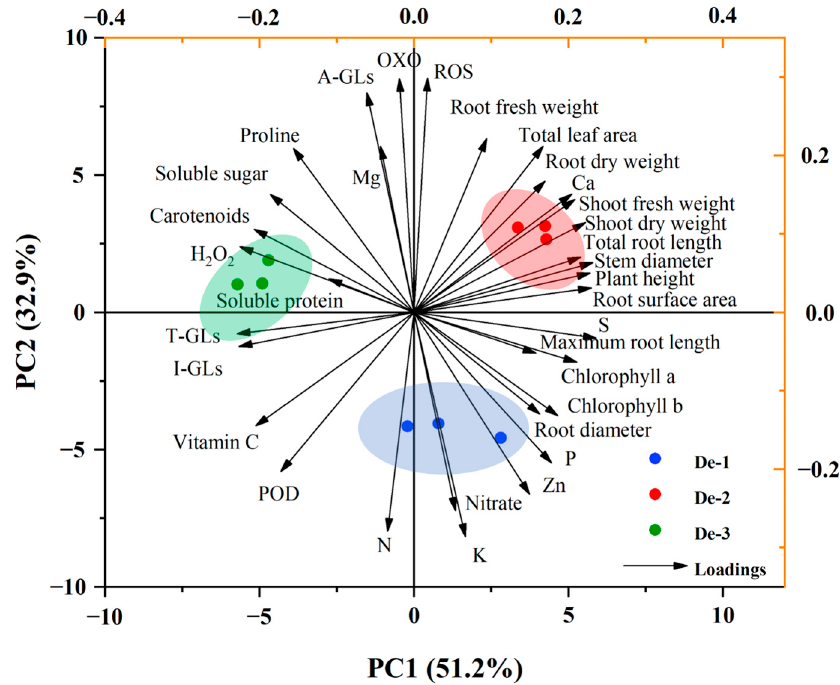
Figure 9. Principal component analysis (PCA) shows differences and correlations in kale grown under different nutrient-solution depths. Scatter plots with different colors indicated three treatments ( n = 3). ROS, reactive oxygen species; H 2 O 2 , hydrogen peroxide; OXO, oxalate oxidase; POD, peroxidase; A-GLs, aliphatic glucosinolates; I-GLs, indole glucosinolates; T-GLs, total glucosinolates; N, nitrogen; P, phosphorous; K, potassium; Ca, calcium; Mg, magnesium; S, sulfur; Zn, zinc.